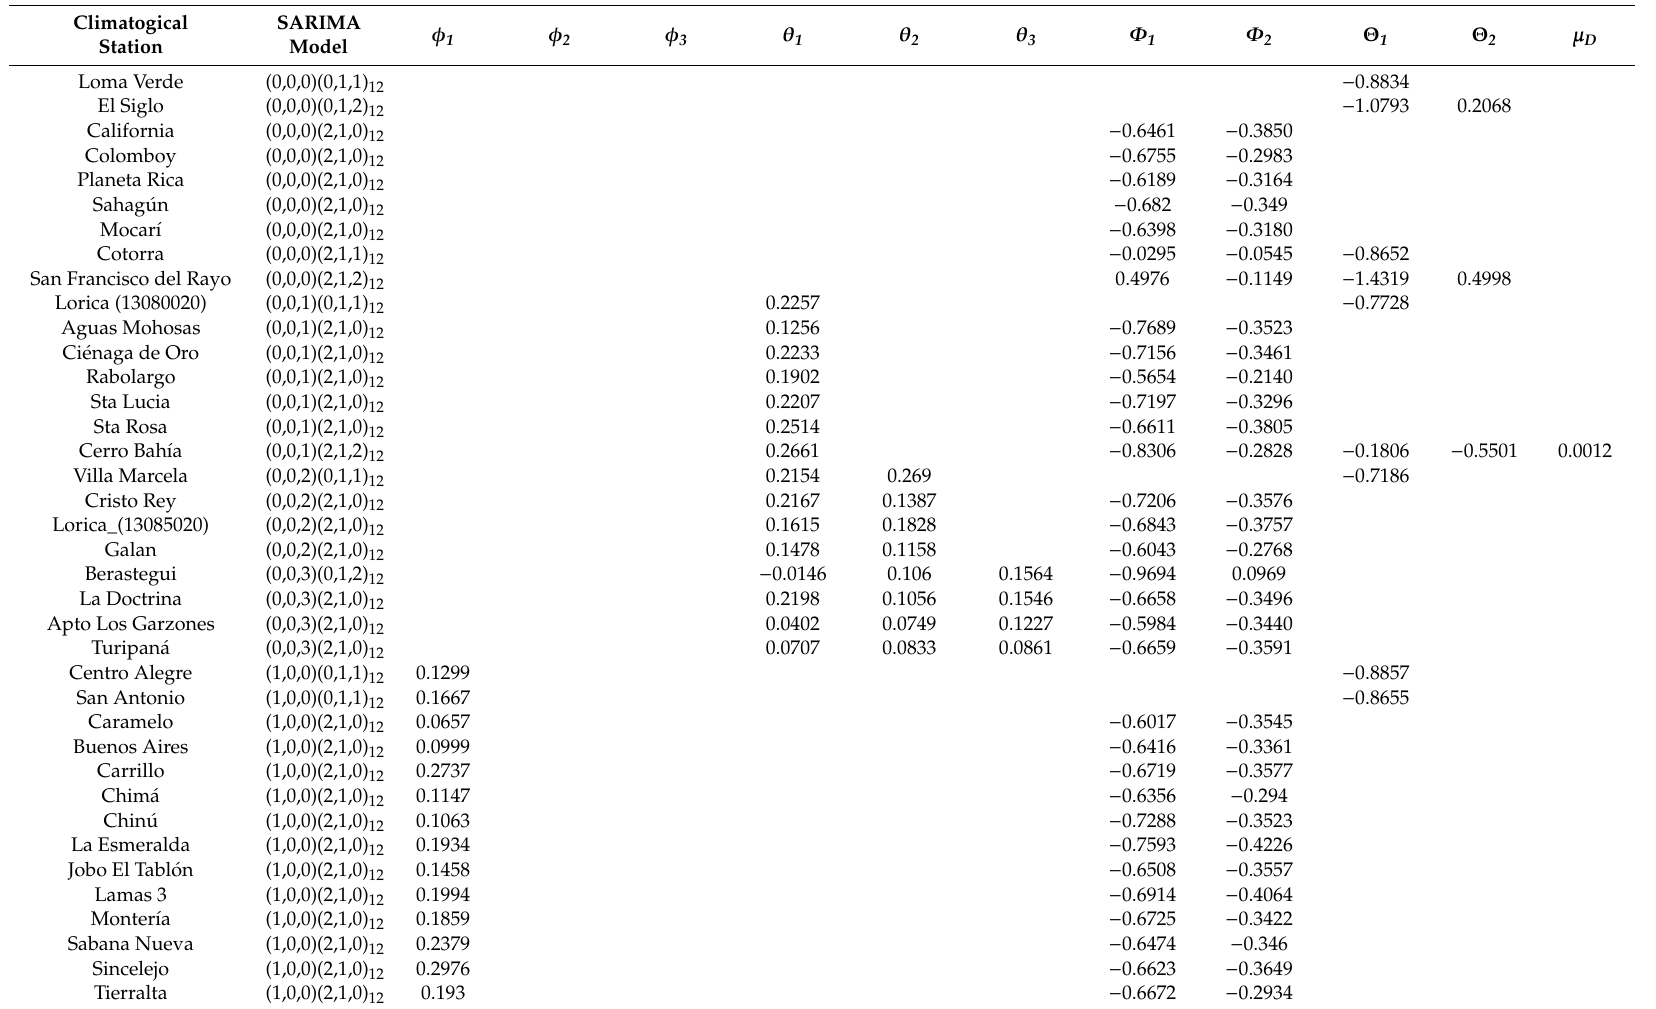
Table 3. SARIMA models for modeling and forecasting the monthly rainfall in the Sin ú river watershed in